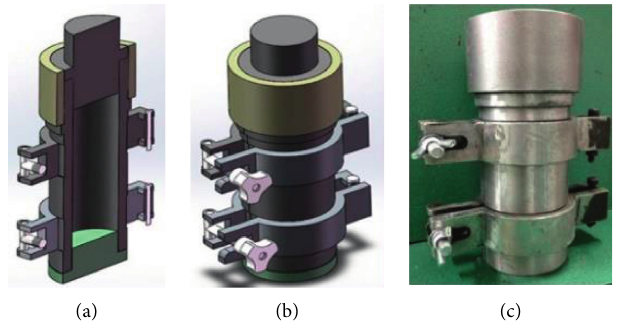
Figure 1: The specimen mould.